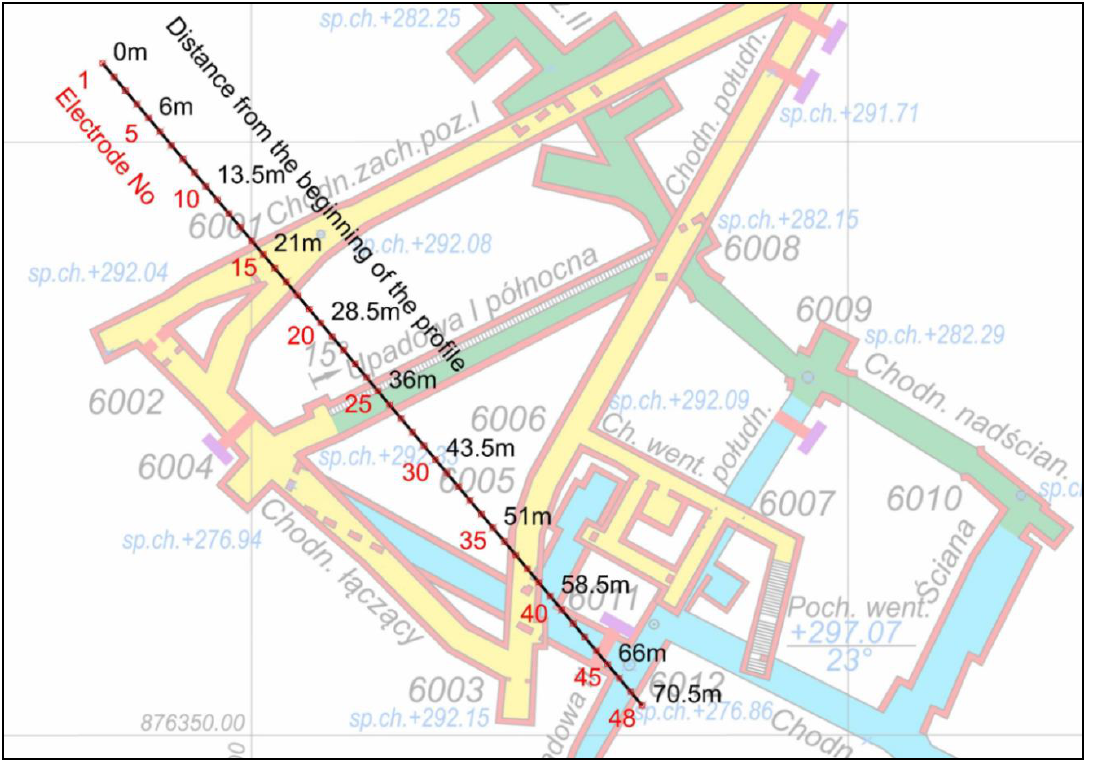
Figure 8. The location of the ERT survey profile in relation to the underground workings.